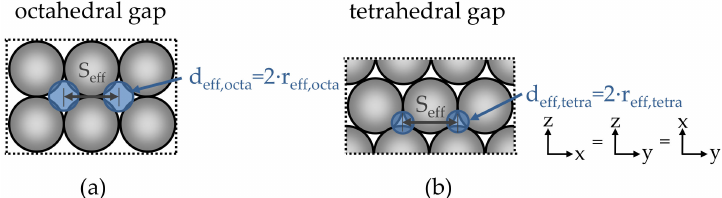
Figure 12. 3D capillary system of the particle bed with ( a ) octahedral and ( b ) tetrahedral gaps; d eff : Diameter of the permeable capillaries; r eff : Radius of the permeable